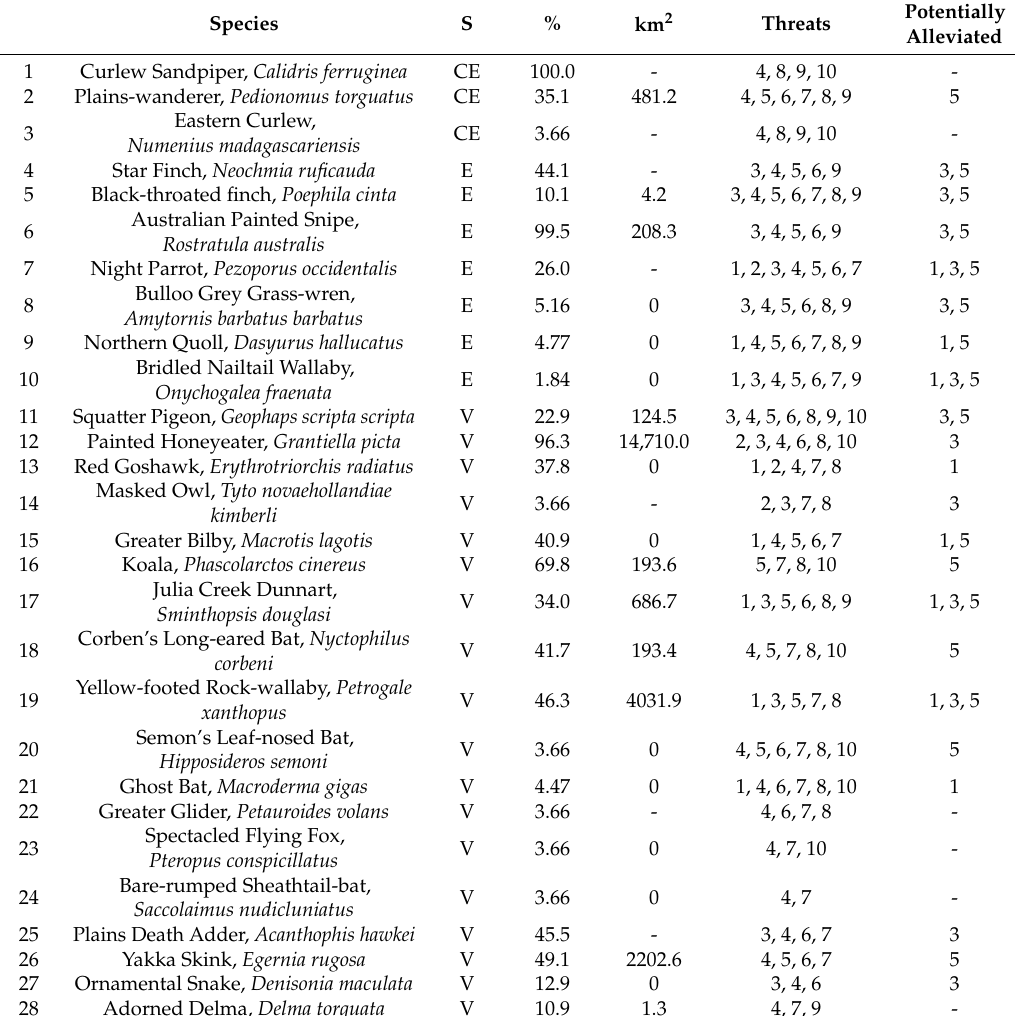
Table 1. List of threatened species recorded in Protected Matters Search Tool reports and their key threats. The list of threatened species identified by PMST reports to be present within clusters. Table lists their threat level status (S): critically endangered (CE), endangered (E) and vulnerable (V). ( % ) shows the percentage of clustered land the species may appear in based on assumed 100% occupancy per cluster. (km 2 ) details the area of potential species distribution in km 2 within clusters (where data exists—QSpatial). The “potentially alleviated” threats only identify those threats being directly mitigated within clusters and do not identify the additional threats being indirectly mitigated within